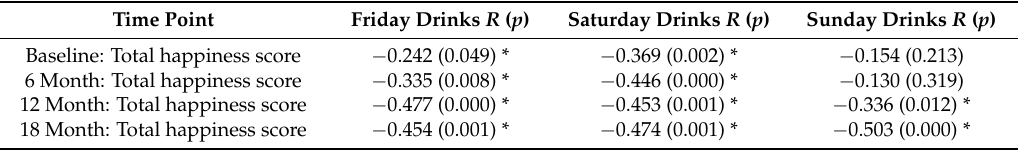
Table 3. Correlations between general happiness and drinking quantities on each day of the weekend.